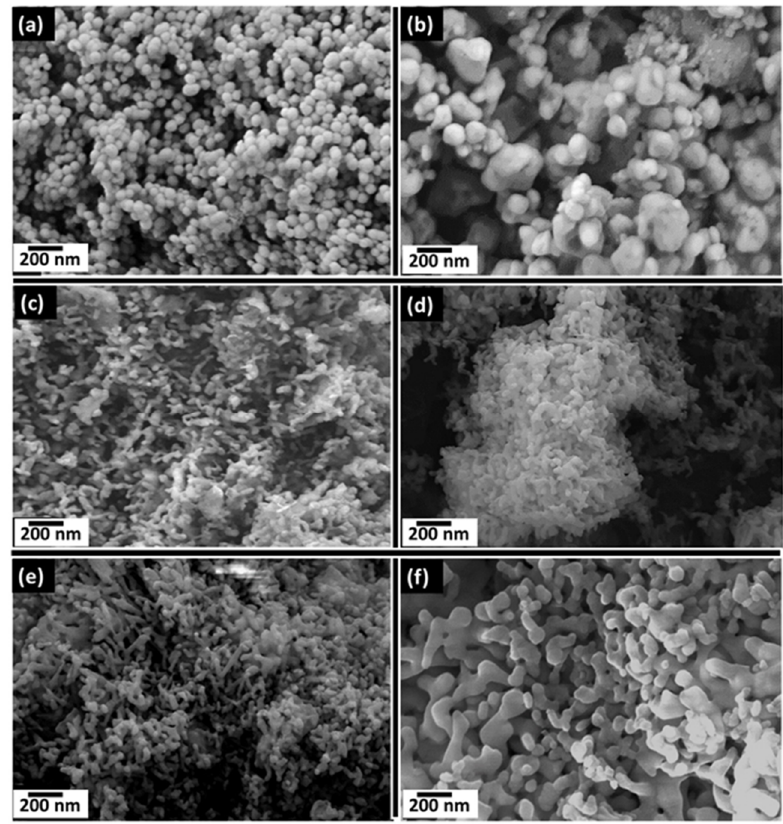
Figure 4. SEM images of HA ( a ), Se-Sr HA 0.01 ( b ), Se-Sr-HA 0.03 ( c ), Se-Sr HA 0.05 ( d ), Se-Sr HA 0.1 ( e ), and Se-Sr HA 0.2 ( f ) powders sintered at 900 °C.